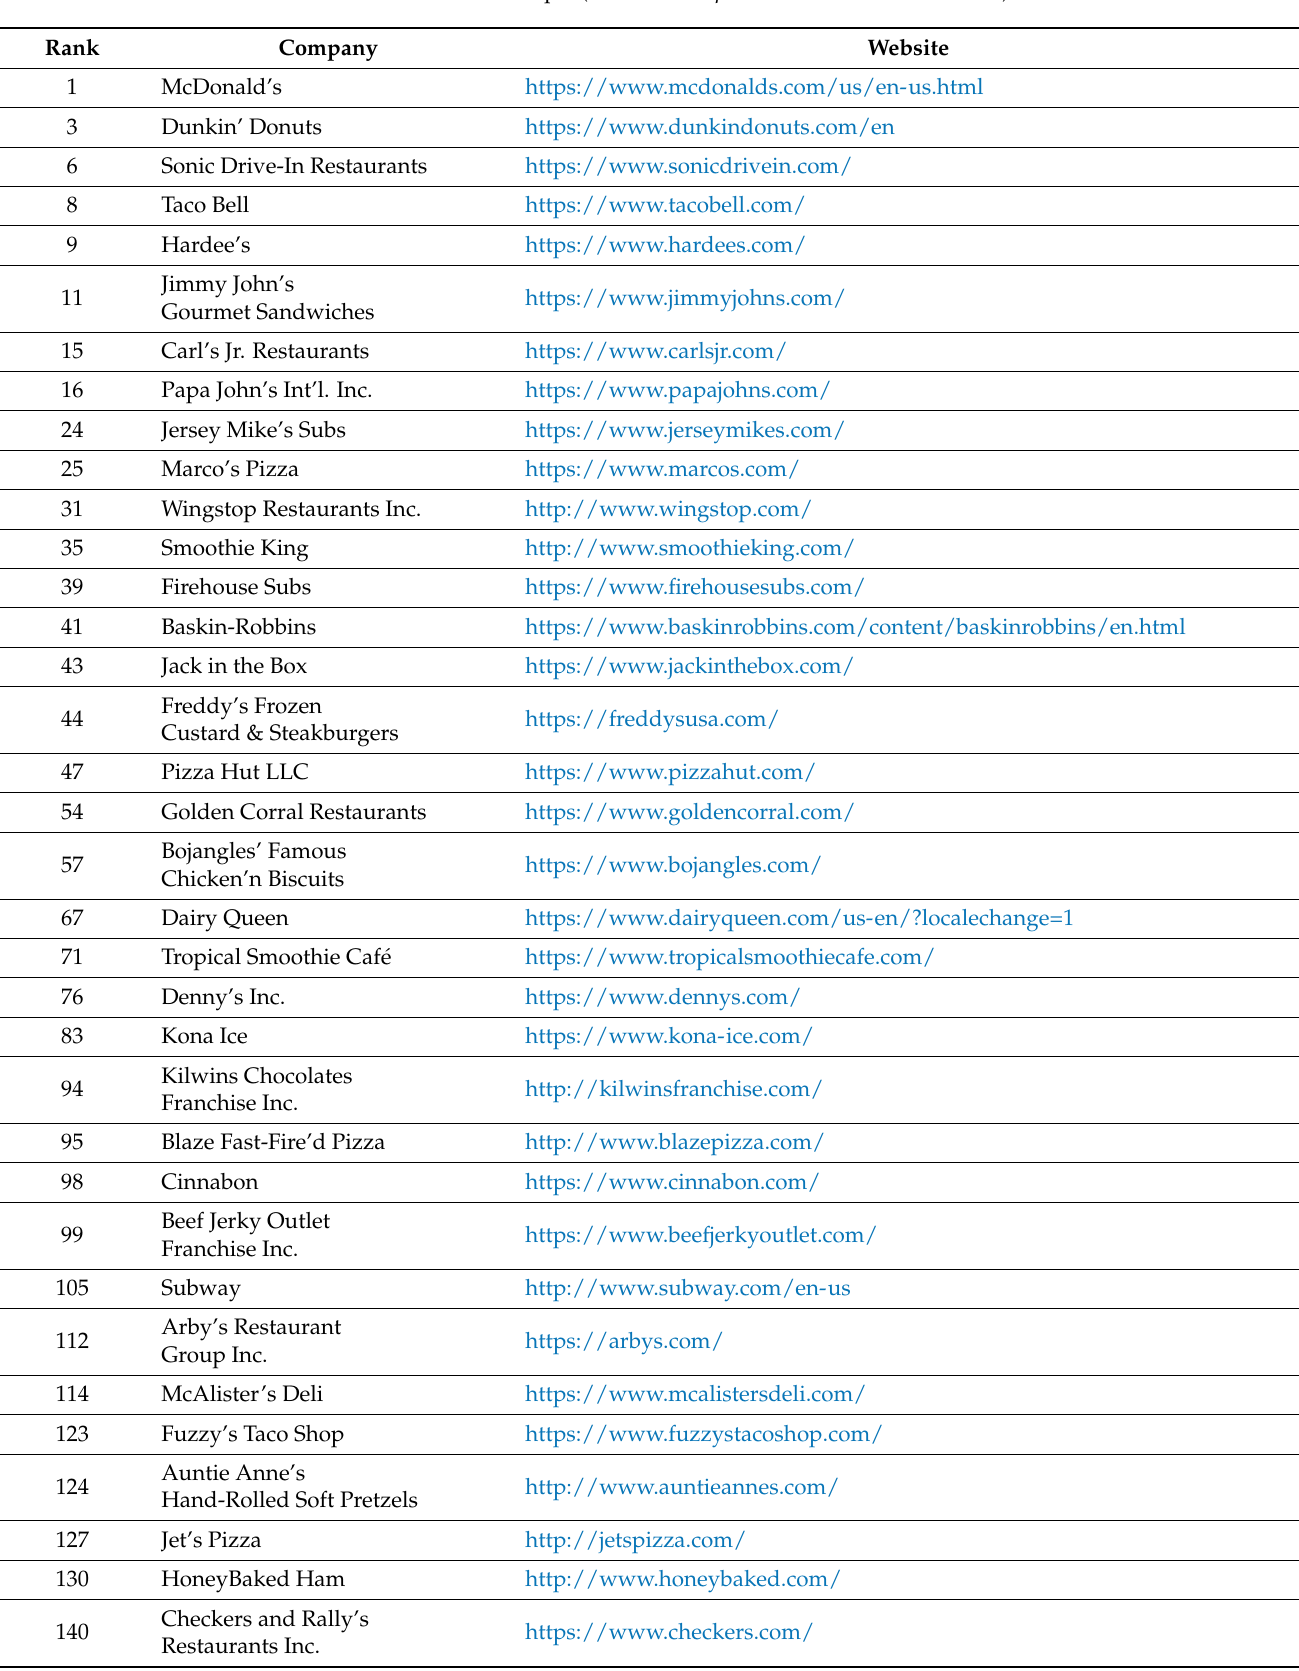
Table 2. Research sample (source: Entrepreneur Franchise 500 in